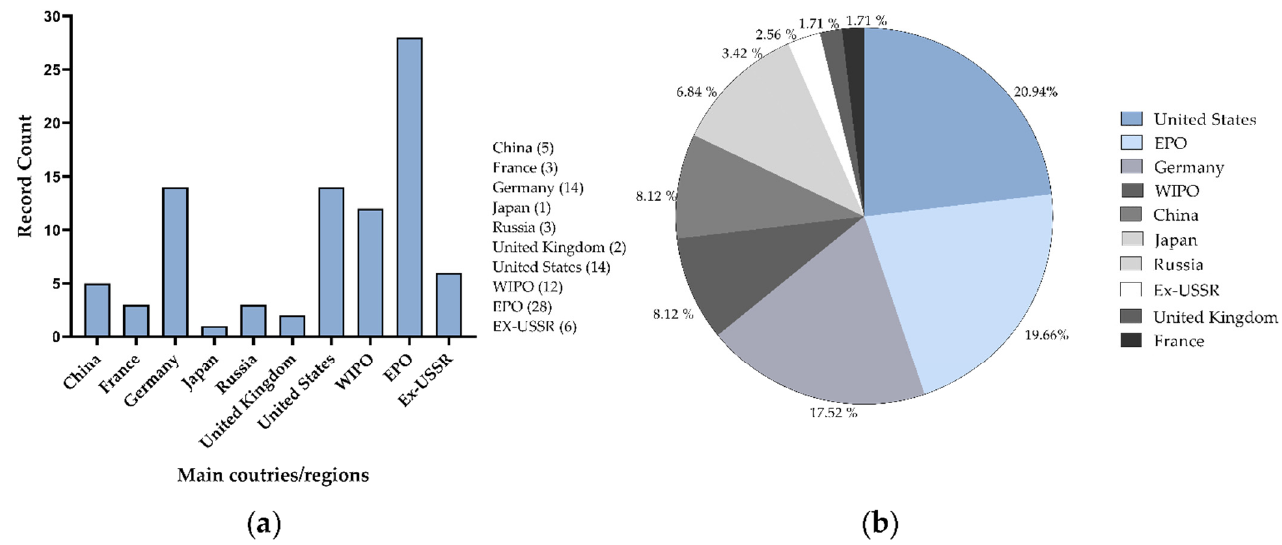
Figure 3. Geographical distribution of the analysis of the ( a ) main countries/regions of the depositors of the prospected technologies with their number of patent documents and ( b ) main markets for these inventions. EPO—European Patent Office; WIPO—World Intellectual Property Organization; USSR—Union of Soviet Socialist Republics (The others 9.4% not highlighted in the figure refers to other countries found in the search).